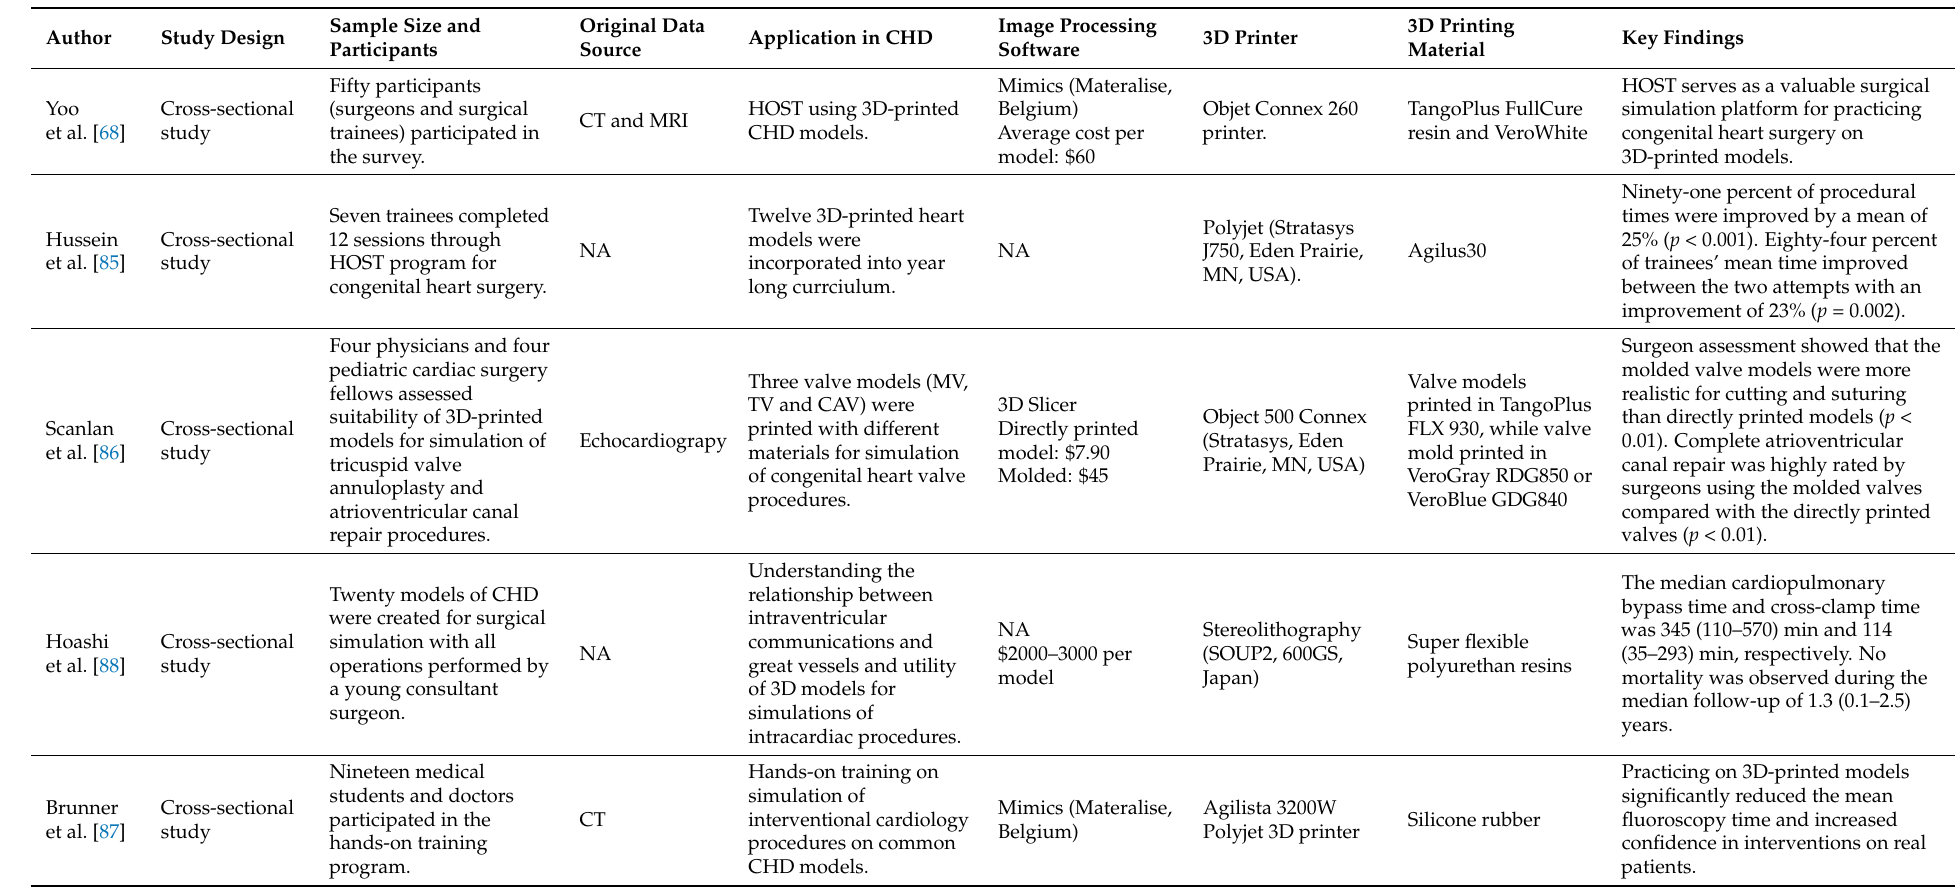
Table 4. Clinical applications of 3D-printed models for HOST in congenital heart surgery procedures. Modified from Sun and Wee